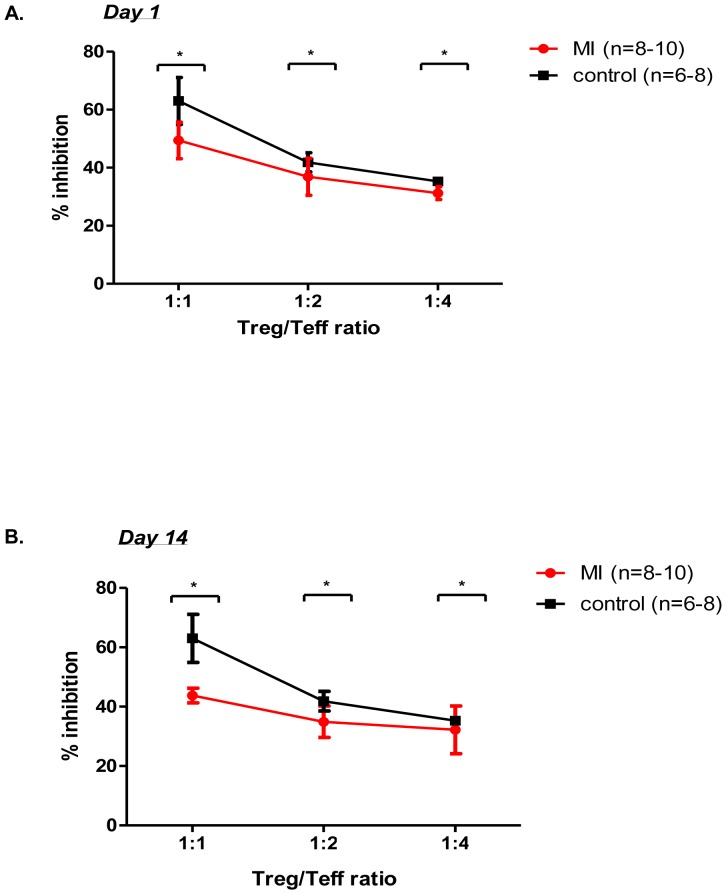
Suppressive properties of Tregs.Assay of functional suppression assay (A–B) shows a trend towards decline in the suppressive properties of Tregs, with significant effects at two time points after experimental induction of myocardial infarction at all ratios. p based on Two-way ANOVA; * p<0.05 based on Mann-Whitney test, n =  6–10;